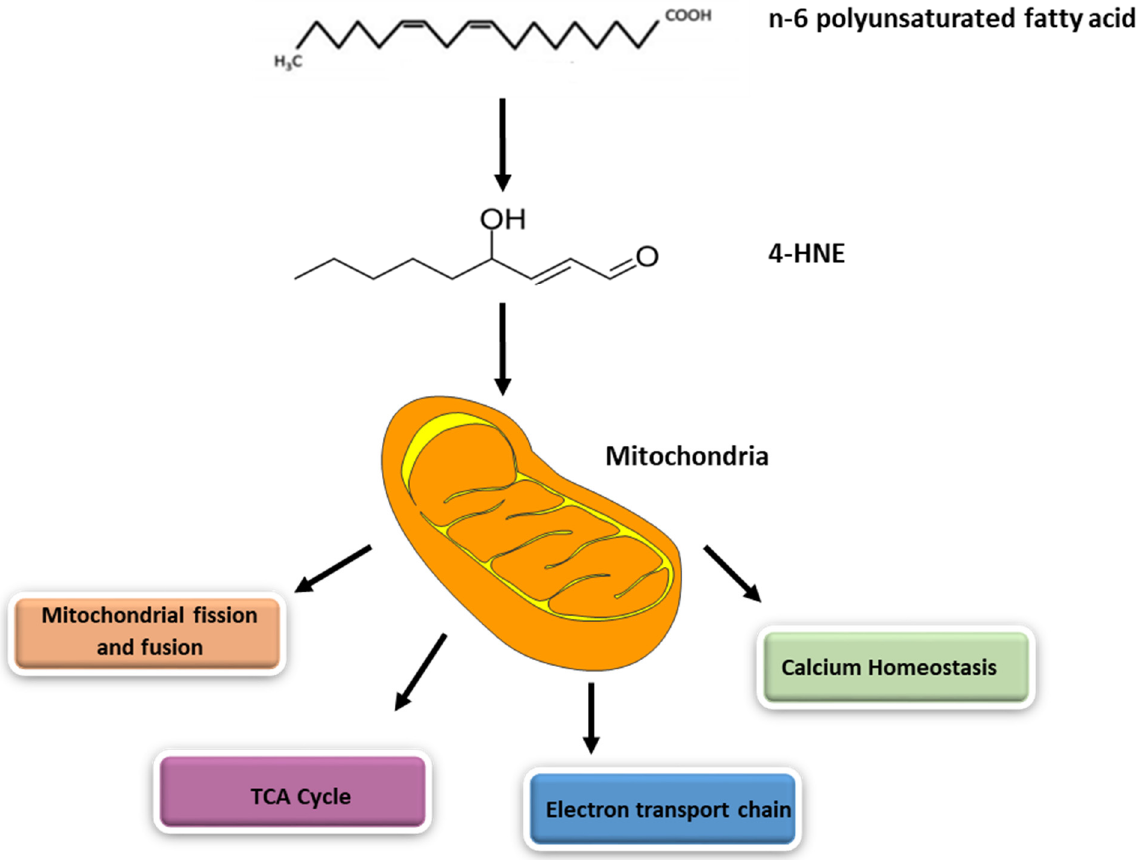
Figure 1. 4-HNE generated after peroxidation of n-6 fatty acid affects various aspects of mitochondrial function such as electron transport chain, TCA cycle, mitochondrial fission, mitochondrial fusion, and calcium homeostasis.